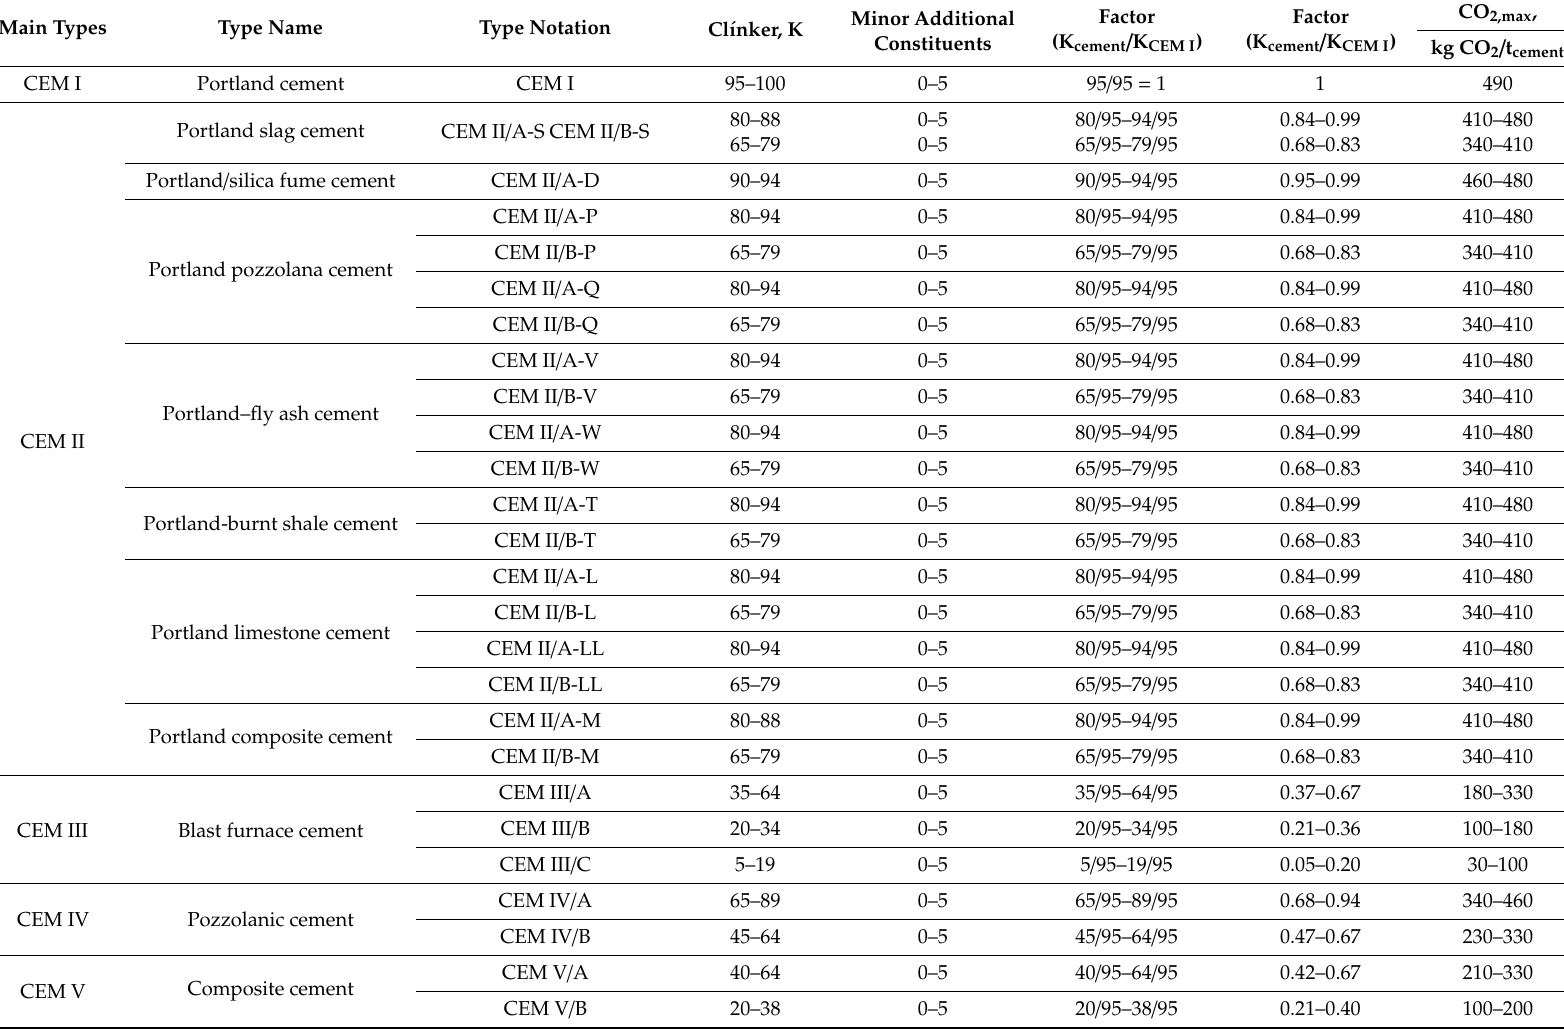
Table 2. Maximum amount of carbon dioxide, CO 2 max , that the di ff erent cements (EN 197-1:2011) can